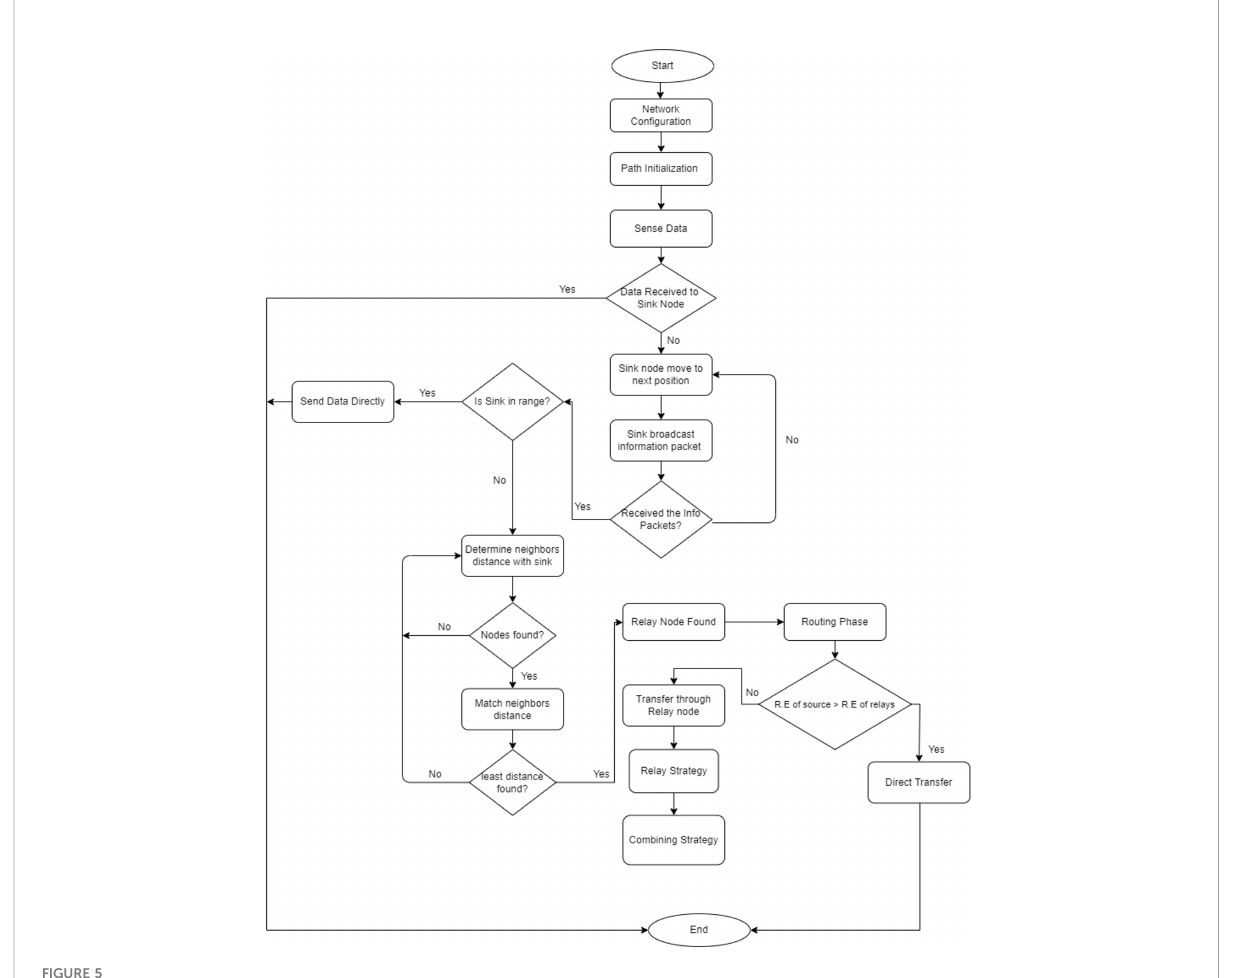
FIGURE 5 Flow chart of the proposed RACE-SM routing